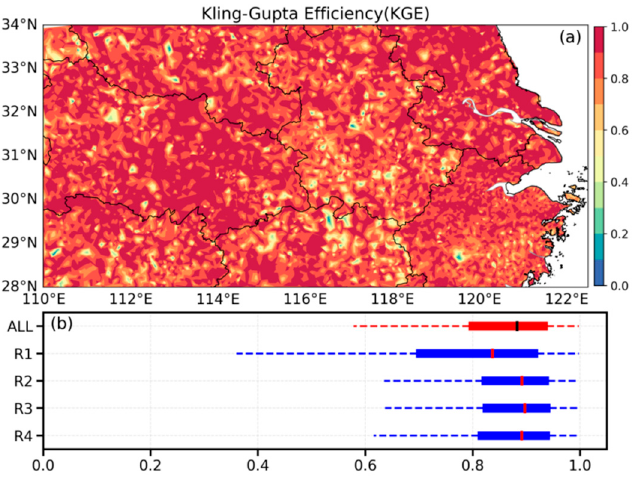
Figure 6. ( a ) Spatial distributions of KGE metric of the CMPAS-NRT product in the Meiyu monitoring area during the 2020 Meiyu period. ( b ) Boxplots of the CMPAS-NRT product for KGE metric in the rain monitoring area.